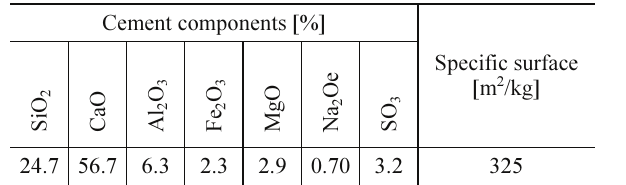
Table 8. Chemical characteristics of CEM II/ B-S 32,5 R